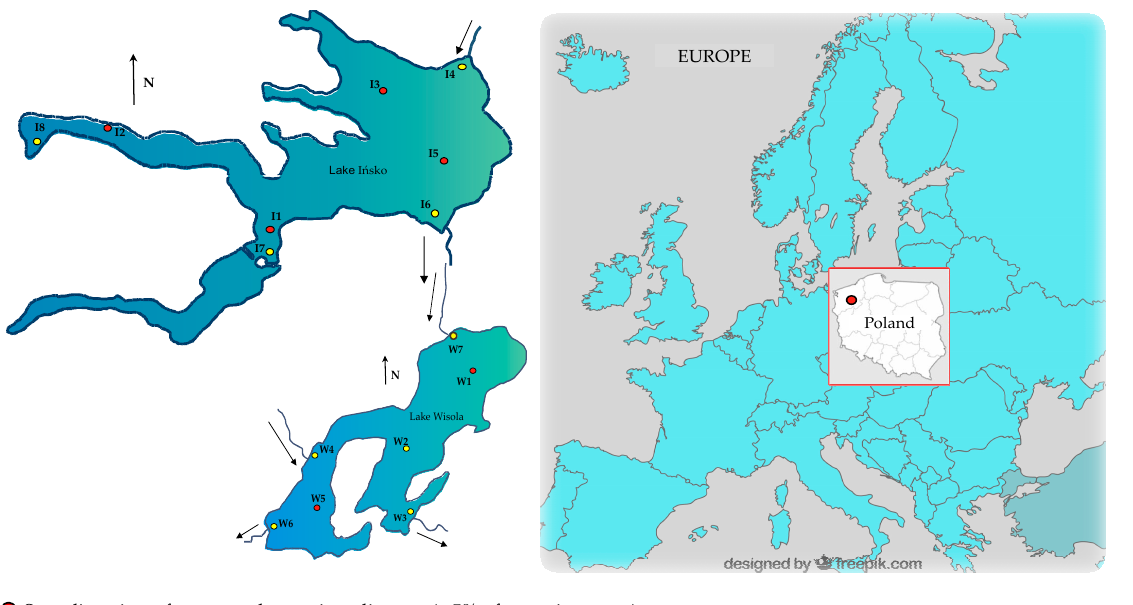
Figure 1. Location of the sampling sites for abiotic and biotic components of lakes I ń sko and Wisola (north ‐ western Poland).